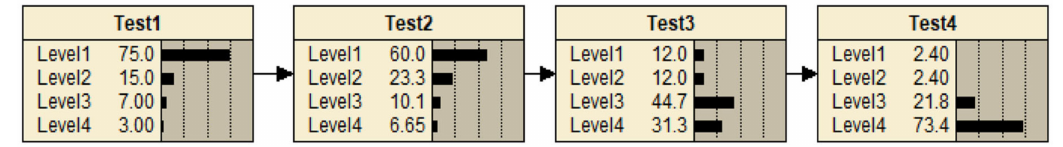
Figure 10. Level change of the third learner in